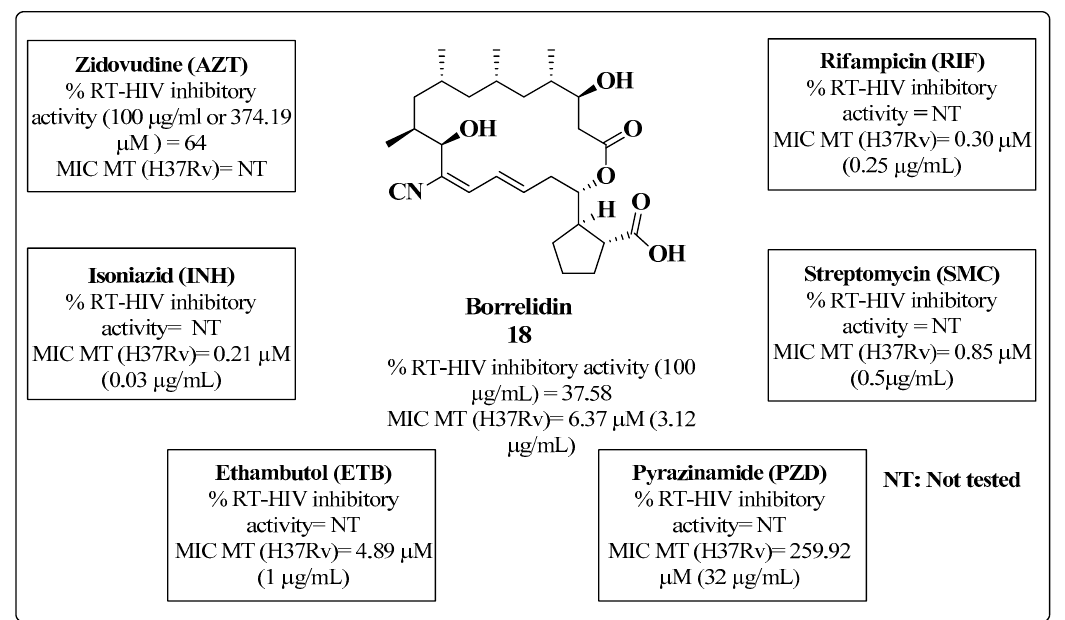
Figure 17. Anti-HIV and anti-MTB activities of borrelidin reported by Bhikshapathi et al. in 2010 [95].